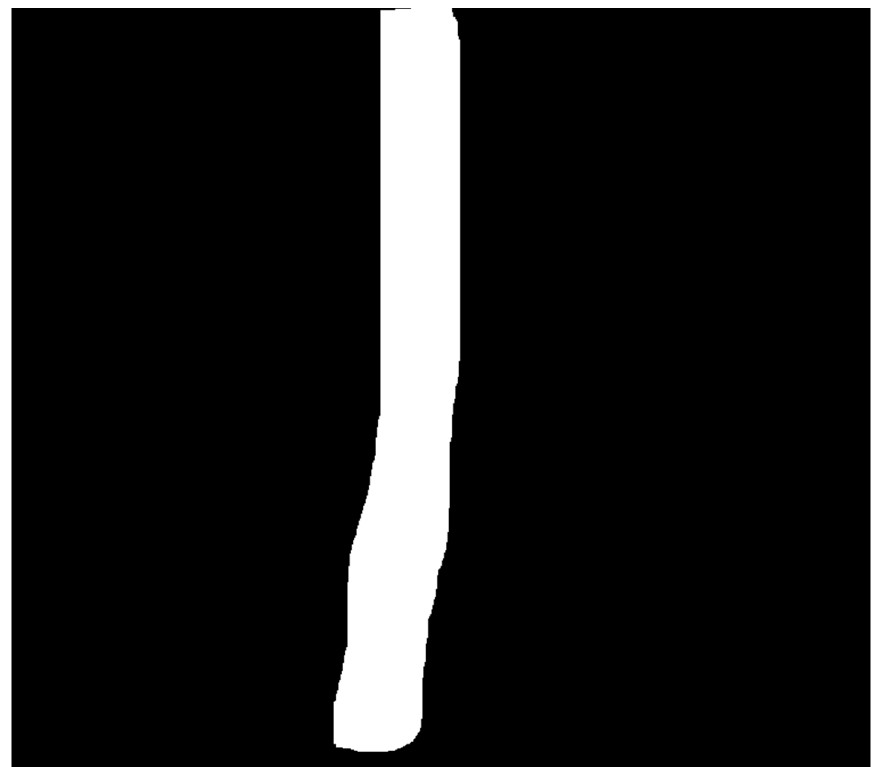
Figure 2. An example of marking up an image with a birch trunk.